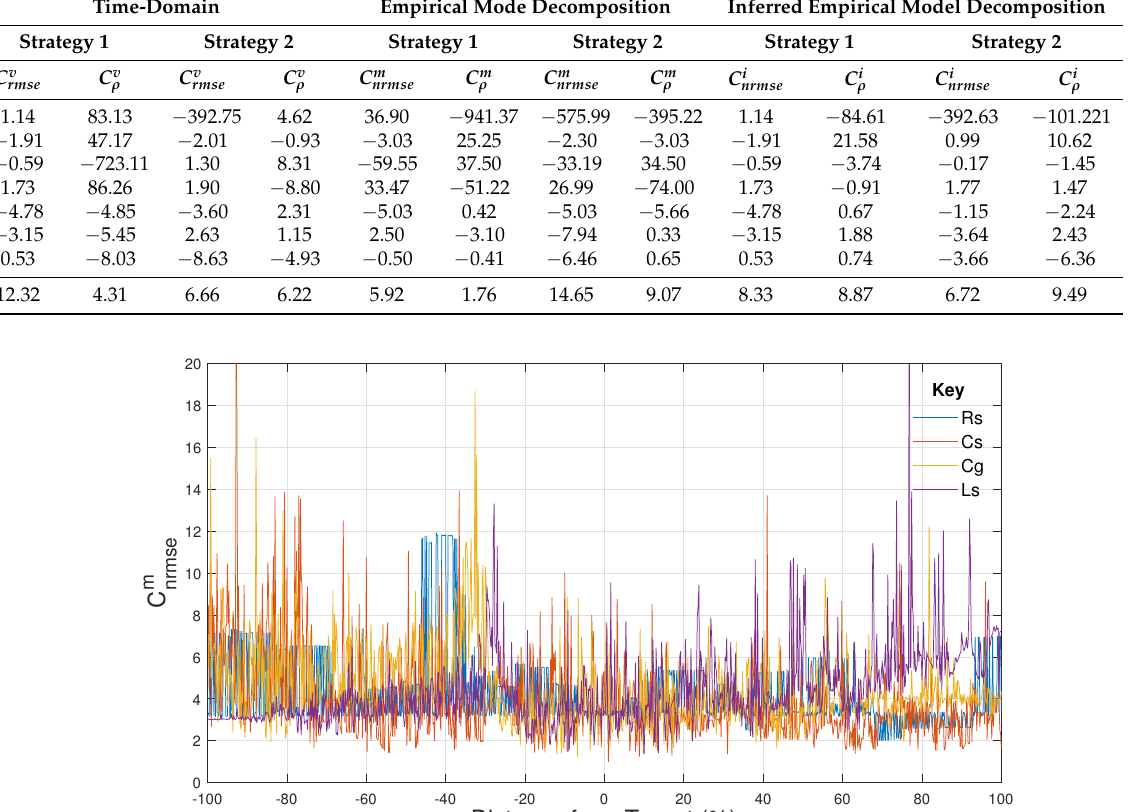
Figure 8. Empirical Mode Decomposition Cost Function C m nrmse versus Distance from the Target Model Parameter [28]. (© 2023 IEEE. Reprinted, with permission, from EEEIC/I&CPS